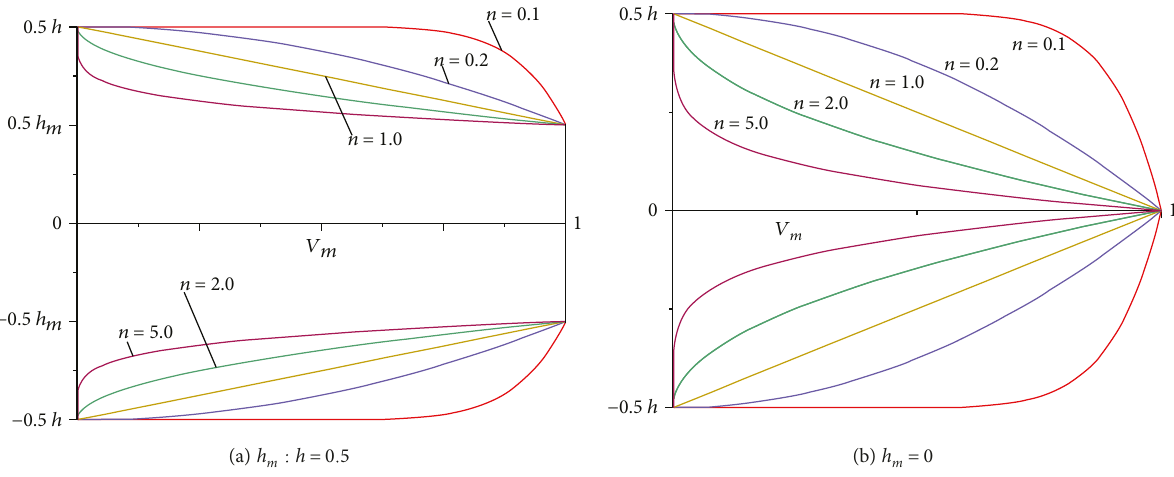
Figure 4: E ff ect of the scalar parameter of volume fraction in the FG sandwich